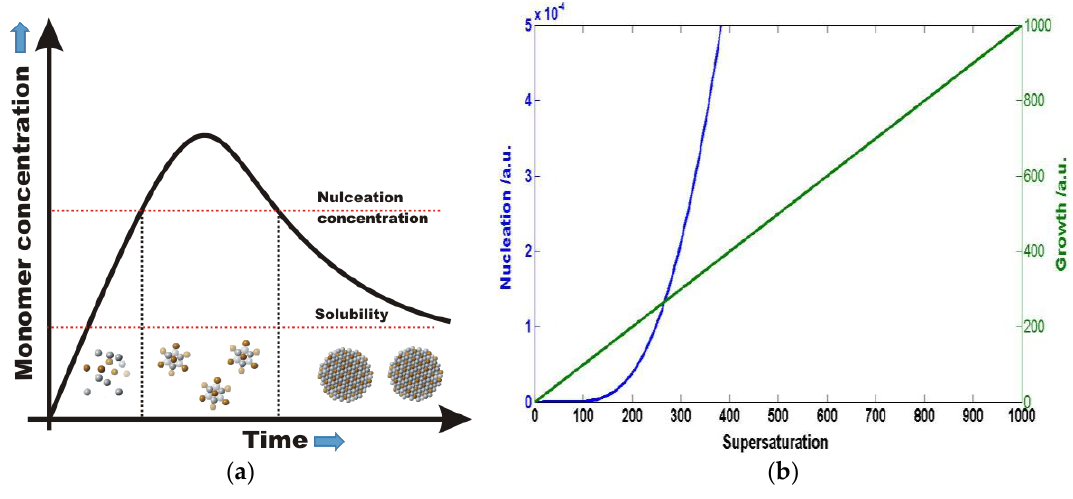
Figure 1. ( a ) LaMer diagram for the nucleation an growth of nanocrystals. ( b ) Dependence of nucleation and growth rate of crystallization on monomer oversaturation S (S = 1 is the solubility of the monomer at any given temperature).